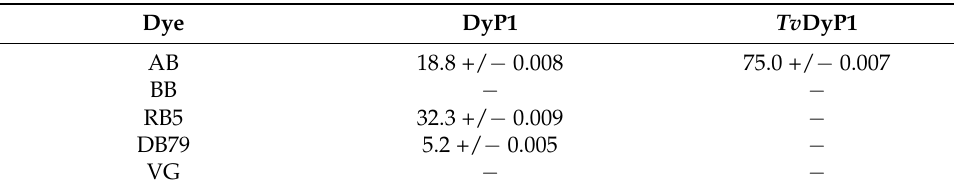
Table 5. Decolorization of industrial dyes by the recombinant DyP a .